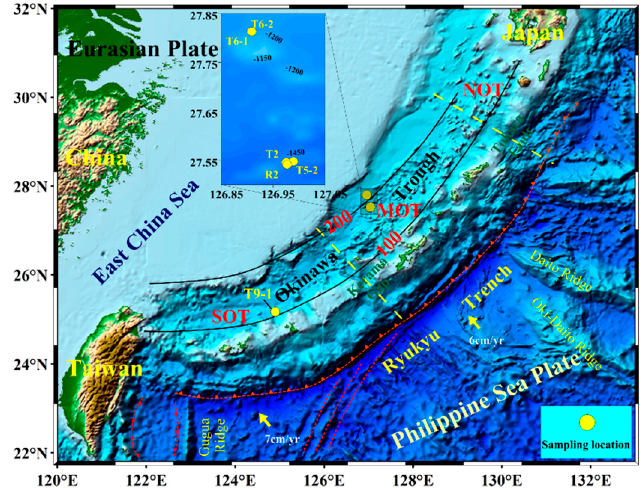
Figure 1. Regional geologic map of the Okinawa Trough (OT) showing the sampling locations. MOT, middle Okinawa Trough; SOT, southern Okinawa Trough; and NOT, northern Okinawa Trough. Black solid lines represent the depth contours of the subducting plate (Wadati-Benioff zone) [11,67,71]. Yellow dotted lines mark the Tokara Fault and the Kerama Fault.